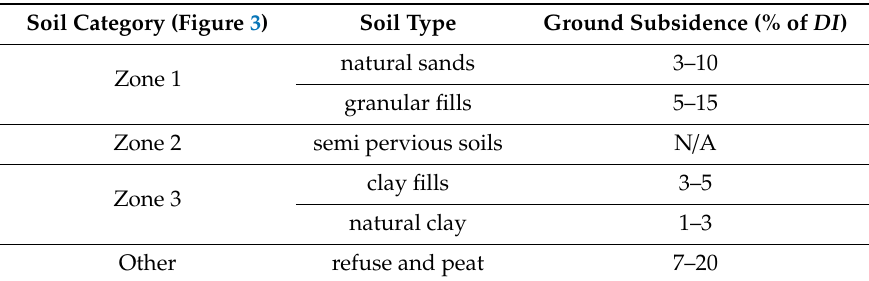
Table 5. Surface subsidence for di ff erent deposits (Solocombe, 1993).